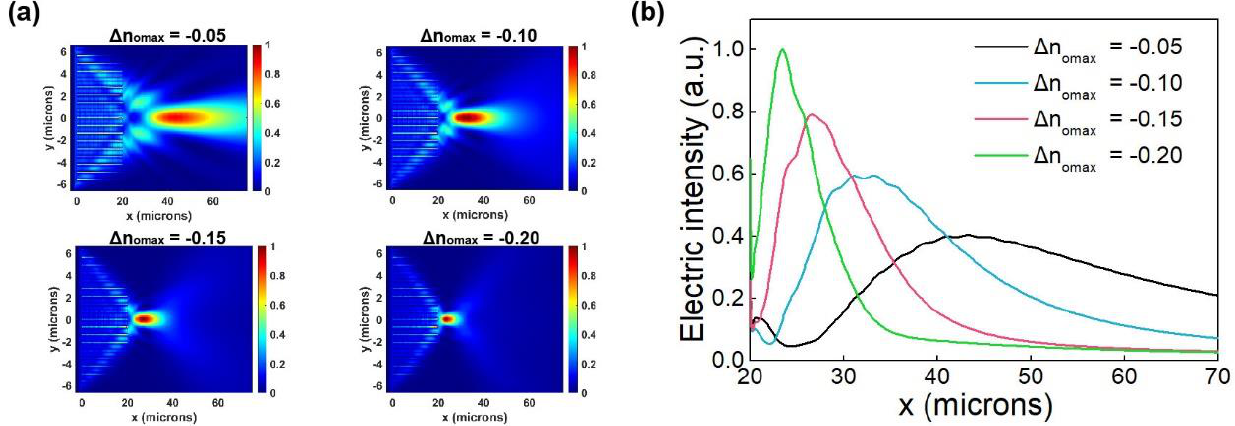
Figure 3. Focusing electric field intensity |E y | 2 distribution. ( a ) Electric field intensity |E y | 2 distribution in the x–y plane of metalens under different voltage groups; Δn omax shown at the top of each figure corresponds to the maximum ordinary refractive index variation due to the voltages applied in all units of the metalens; ( b ) Distribution of normalized electric field intensity of y = 0 cross section versus x coordinates in the metalens. The four curves Δn omax = −0.05 , Δn omax = −0.10 , Δn omax = −0.15 and Δn omax = −0.20 correspond to the metalens at the four voltage groups shown in ( a ), respectively.